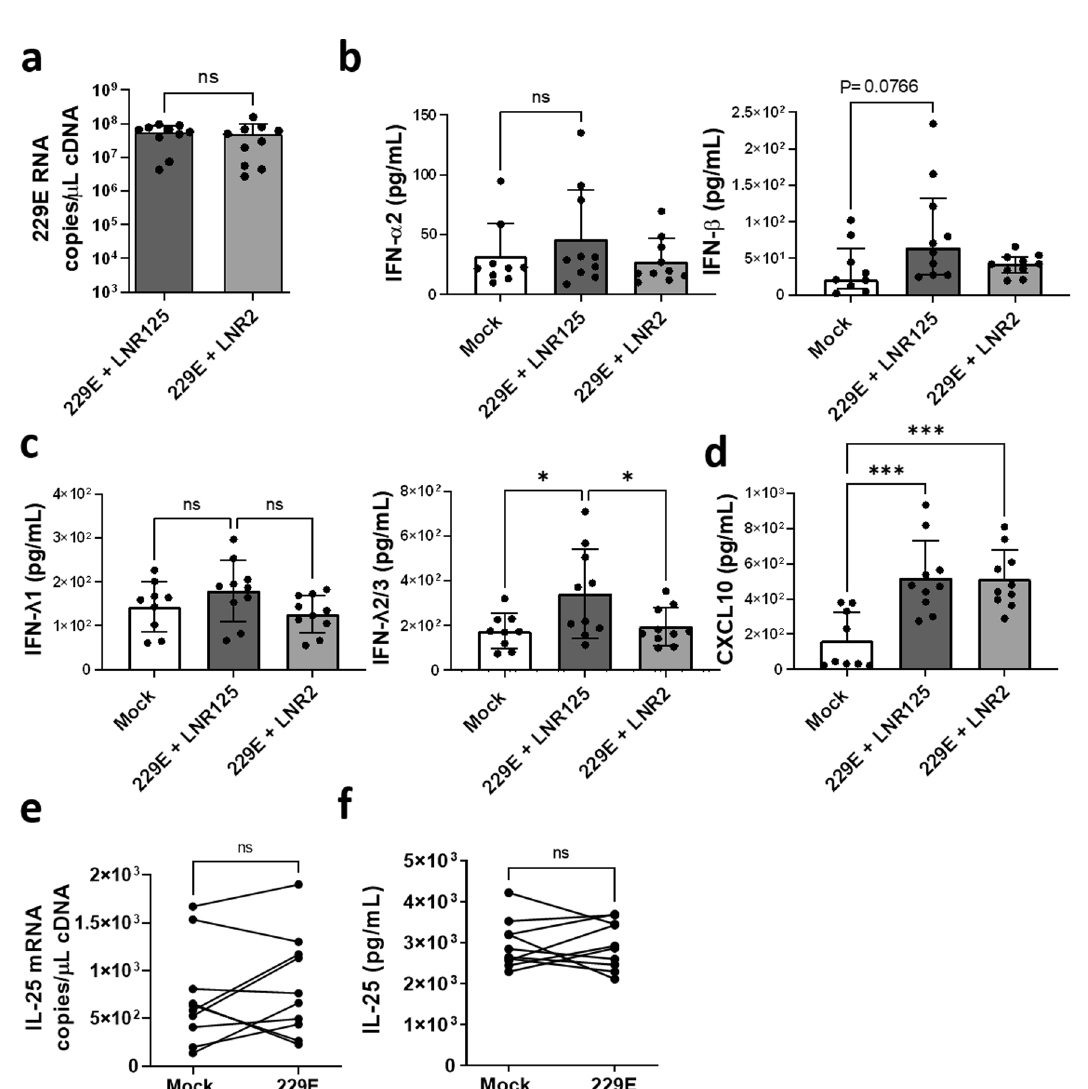
Fig. 4 IL-25 blockade augments IFN- λ expression during 229E infection in healthy BECs. Healthy ALI-differentiated CR cells were pre-treated with LNR125 or LNR2 1 day prior to infection with 229E then harvested for total cellular RNA and cellular protein at day 3 p.i. ( a ) 229E viral load was quanti fi ed by Taqman qPCR analysis ( b – d ) supernatants were collected in PBS and cytokines were analysed using LEGENDplex. ( e ) IL-25 gene expression and ( f ) protein levels in supernatants quanti fi ed by sandwich ELISA. n = 10 biological replicates of two healthy CR donors, mean with SD analysed by ( a ) paired T-test, ( b – d ) one-way ANOVA * P < 0.05 , ** P < 0.01, *** P < expression (Fig. 4c) but did not increase virus-induced CXCL10 differentiation 28 . Five replicate wells each ( n = 10) were treated (Fig. 4d). No signi fi cant difference in IL-25 mRNA or protein with LNR125 then infected with the endemic human coronavirus levels were detected in this context ( Fig. 4e, f ) . 229E 29 . We collected cells and apical supernatants at 3 d.p.i. We did not observe any changes in 229E viral load (viral RNA) with LNR125 treatment (Fig. 4a) or difference in type I IFN protein LNR125 treatment inhibited RV-induced type-2 cytokine expression (IFN- α 2a, IFN- β ) although we did note near sig- production in vivo . We have previously reported that RV ni fi cant increased ( P = 0.0766) IFN- β (Fig. 4b). However, infection augments aeroallergen-induced lung IL-25 expression LNR125 treatment signi fi cantly boosted IFN- λ 2/3 protein associated with increased type 2 lung in fl ammation and blocking